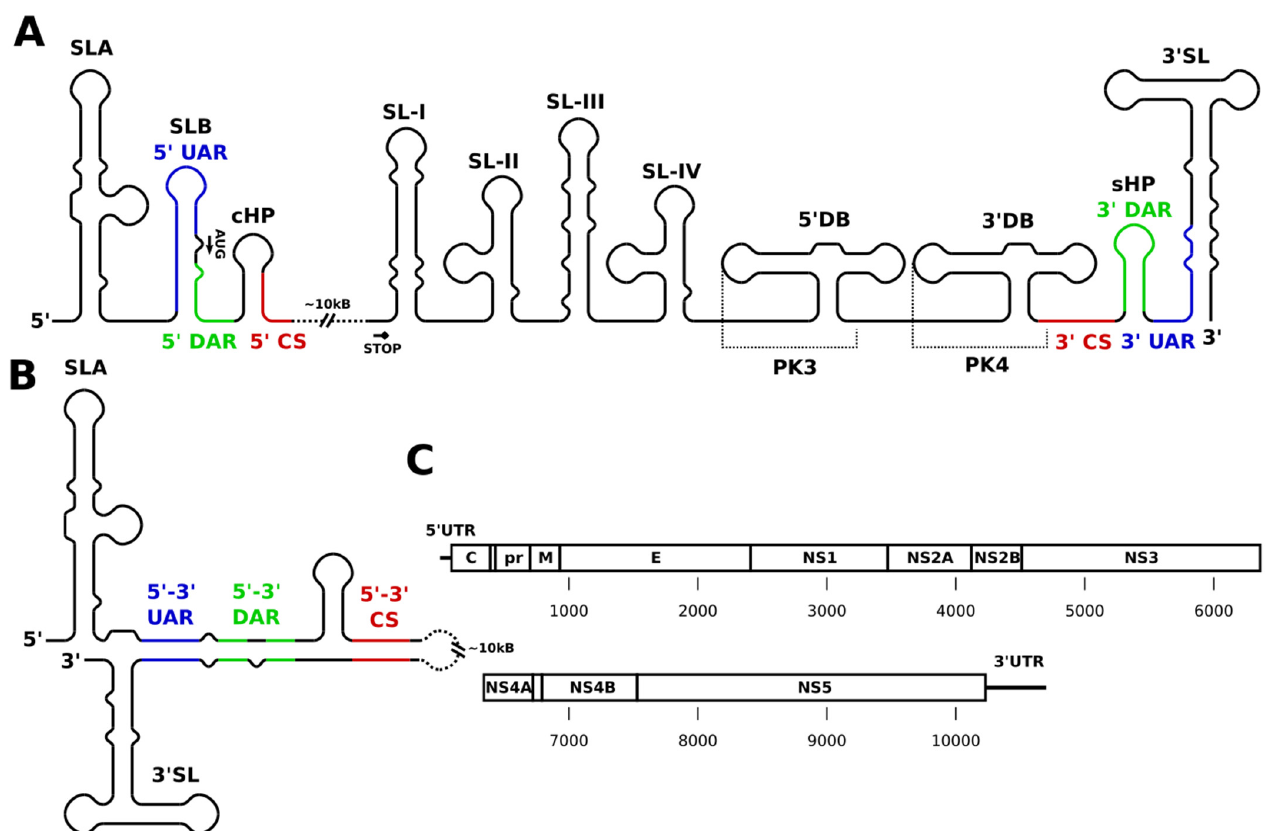
Figure 1. Structural overview of flaviviral genomes. ( A ) Schematic representation of the linear 5 ′ and 3 ′ untranslated region (UTRs). Circularization motifs are indicated and labeled in color. The upstream AUG region (UAR; blue) is followed by the downstream AUG region (DAR; green) and the highly conserved circularization sequence (CS; red). Translation initiation happens within stem loop B (SLB) between 5 ′ UAR and 5 ′ DAR. The order of circularization sequence motifs is inverted in the 3 ′ region. ( B ) The circular form of the genome (paired motifs shown in color). SLB, capsid hairpin (cHP), short hairpin (sHP), and 3 ′ SL undergo structural reorganization upon circularization. ( C ) Overview of flaviviral RNA genes. An ≈ 100 nt 5 ′ UTR is followed by a ≈ 10 kb single open reading frame coding a single genome polyprotein, which is post-translationally processed to form the structural (C, prM, and E) and non-structural proteins comprising the flaviviral proteome. The open reading frame is followed by an ≈ 300–700 nucleotides (depending on species) 3 ′ UTR containing conserved structural elements.